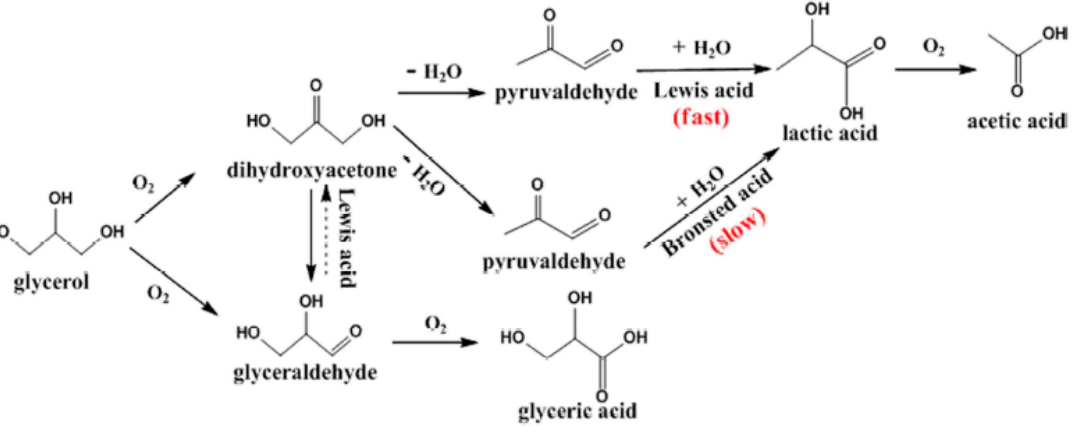
Figure 22. Proposed tandem reaction pathways for the selective oxidation of glycerol to lactic acid over Ag x PMo catalysts. Reprinted with permission from reference [155]. Copyright 2016 Nature Publishing Group.